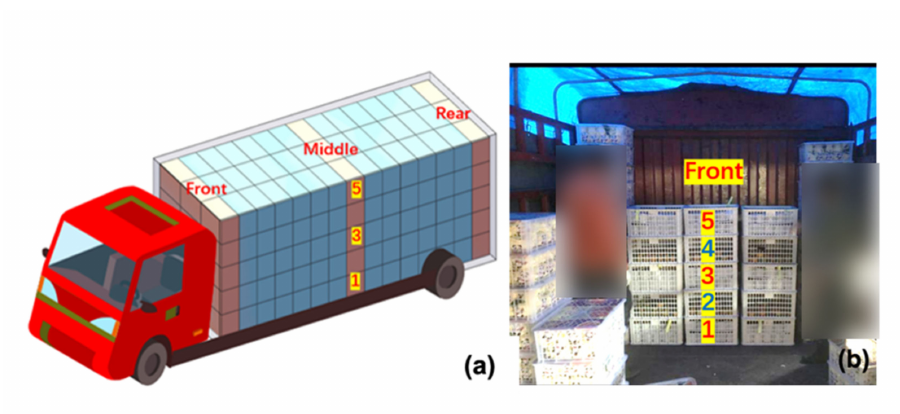
Figure 3. Placement of boxes containing Hongmeiren orange fruit in a lorry: ( a ) Placement of the boxes in the front, middle, and rear of the lorry. ( b ) Placement of the first, third and fifth tiers of the boxes in the front of the lorry. The second and fourth tiers were Citrus reticulata Blanco cv.